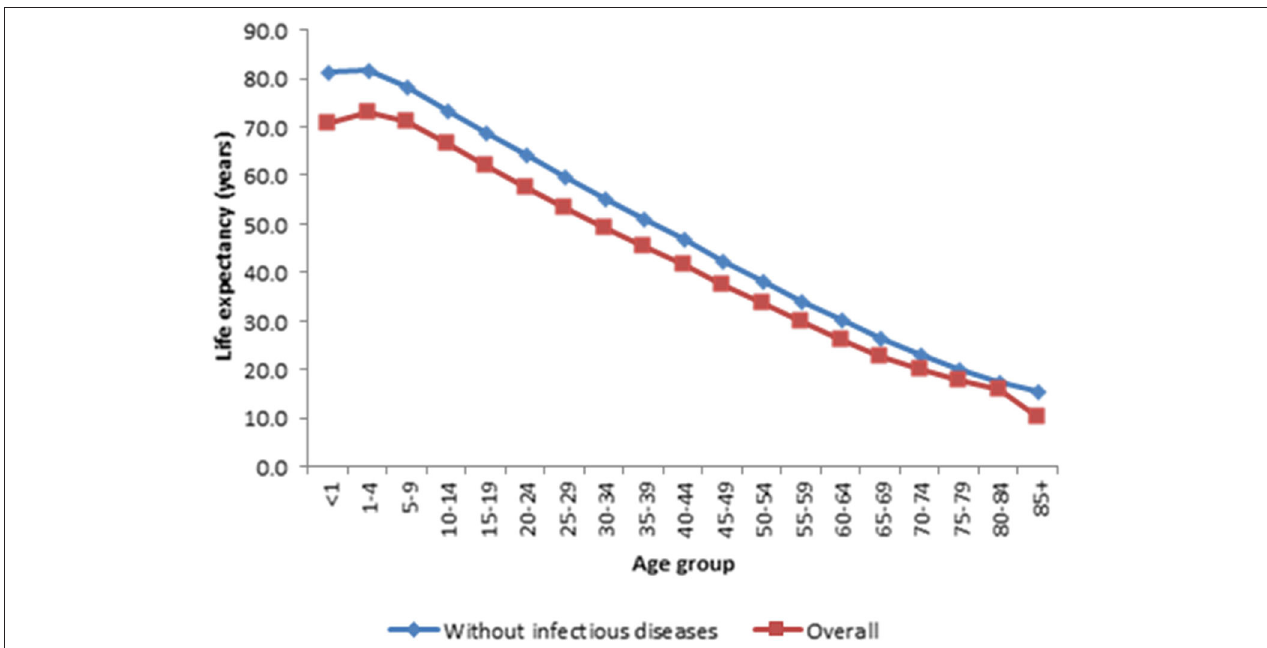
FIGURE 1 | Comparsion of estimated life expectancy for each age group with all cause of death and without infection diseases, Kintampo HDSS (2005–2014). Source: Kintampo HDSS